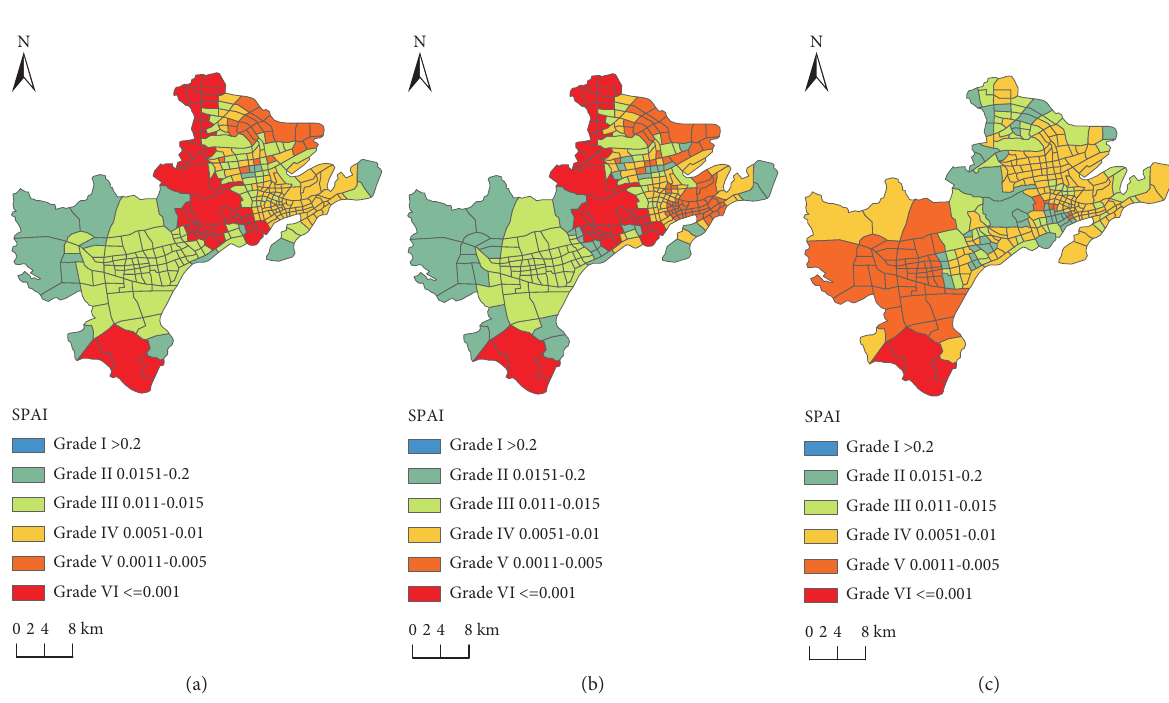
Figure 10: The geographic patterns of accessibility of prehospital emergency medical services with different traffic scenarios. (a) Peak. (b) Flat peak. (c) Free